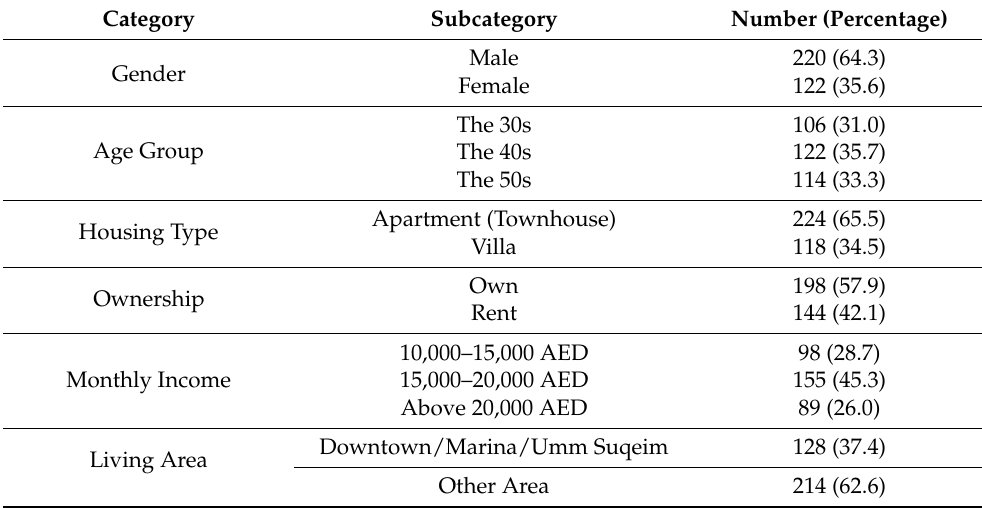
Table 5. The Characteristics of Survey Participants.